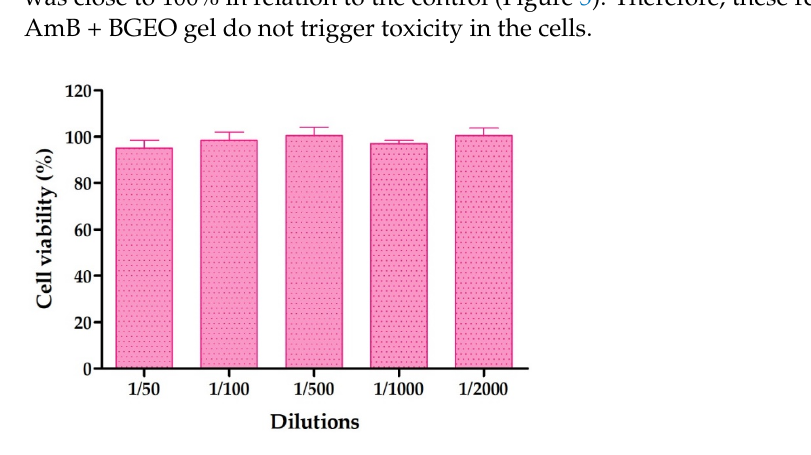
Table 4. MIC against different cultures of Candida spp., Free AmB, AmB gel, AmB+BGEO gel and B. graveolens essential oil (BGEO) after incubation at 30 °C for 48 h ( n = 3).